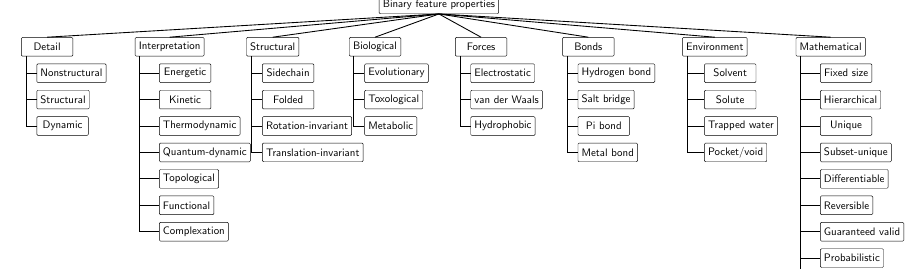
Figure 5. Taxonomy of categorical feature properties.